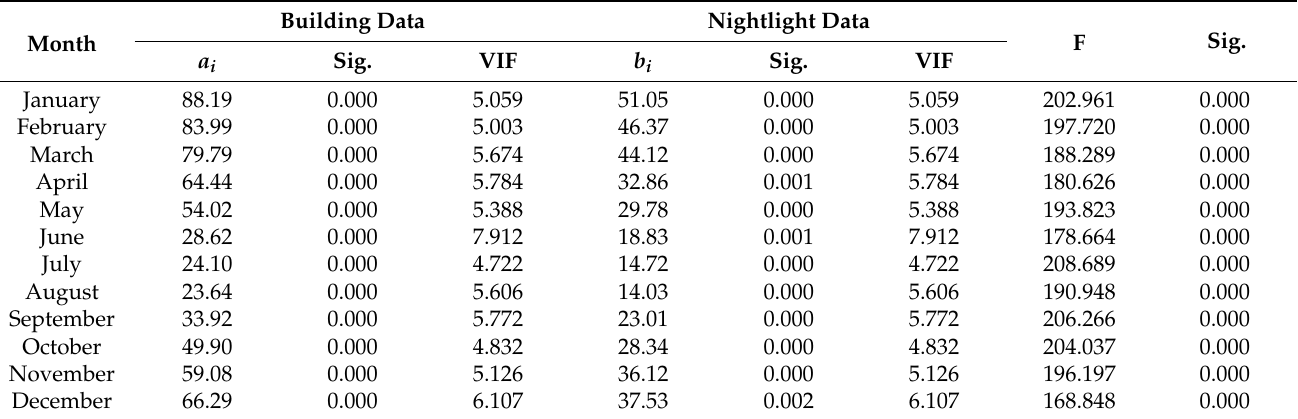
Table 2. Coefficients of models in different